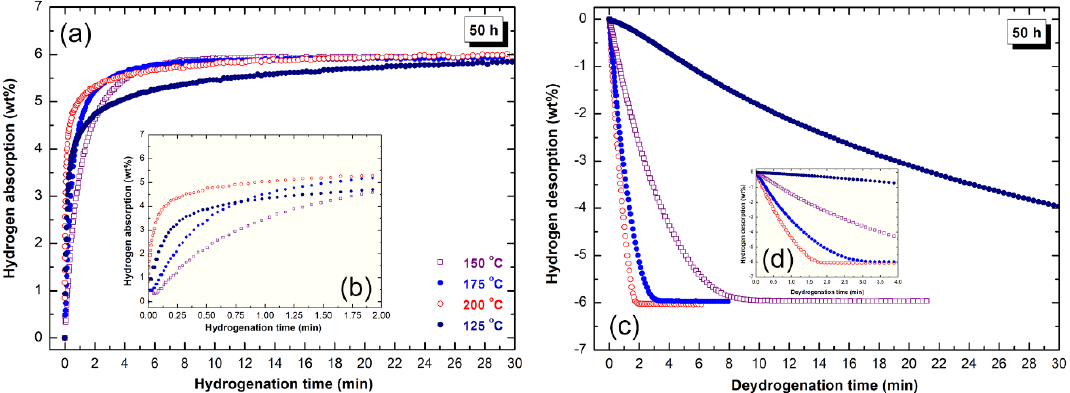
Figure 11. Kinetics of ( a , b ) hydrogenation and ( c , d ) dehydrogenation of rod-milled MgH 2 /7 wt% a-LaNi 3 for 50 h. The measurements were conducted at different temperature under hydrogen pressure of 10 bar and 200 mbar, respectively.